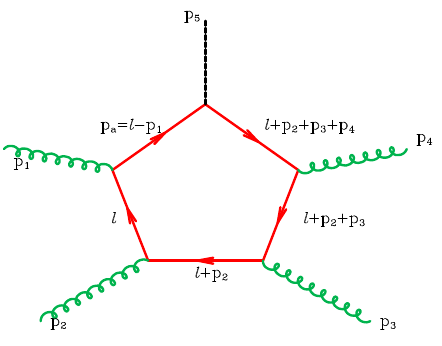
Figure 2 . Feynman diagram to illustrate the calculation of coefficient the scalar pentagon